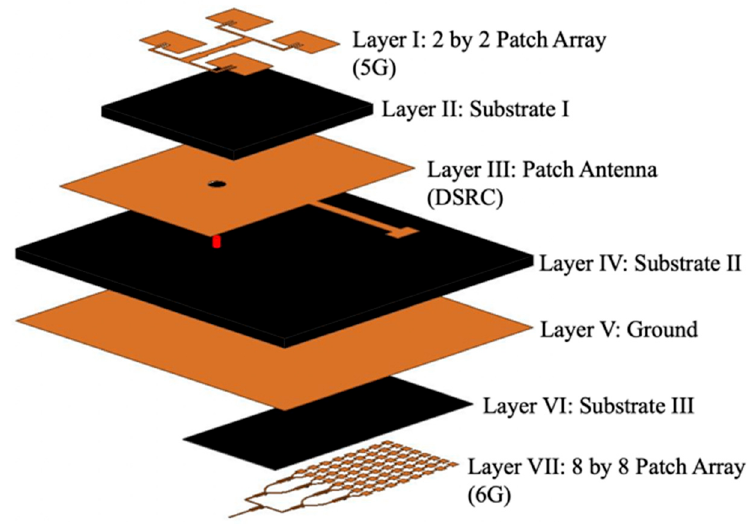
Figure 1. Expanded view of the low-profile triple-frequency antenna structure.